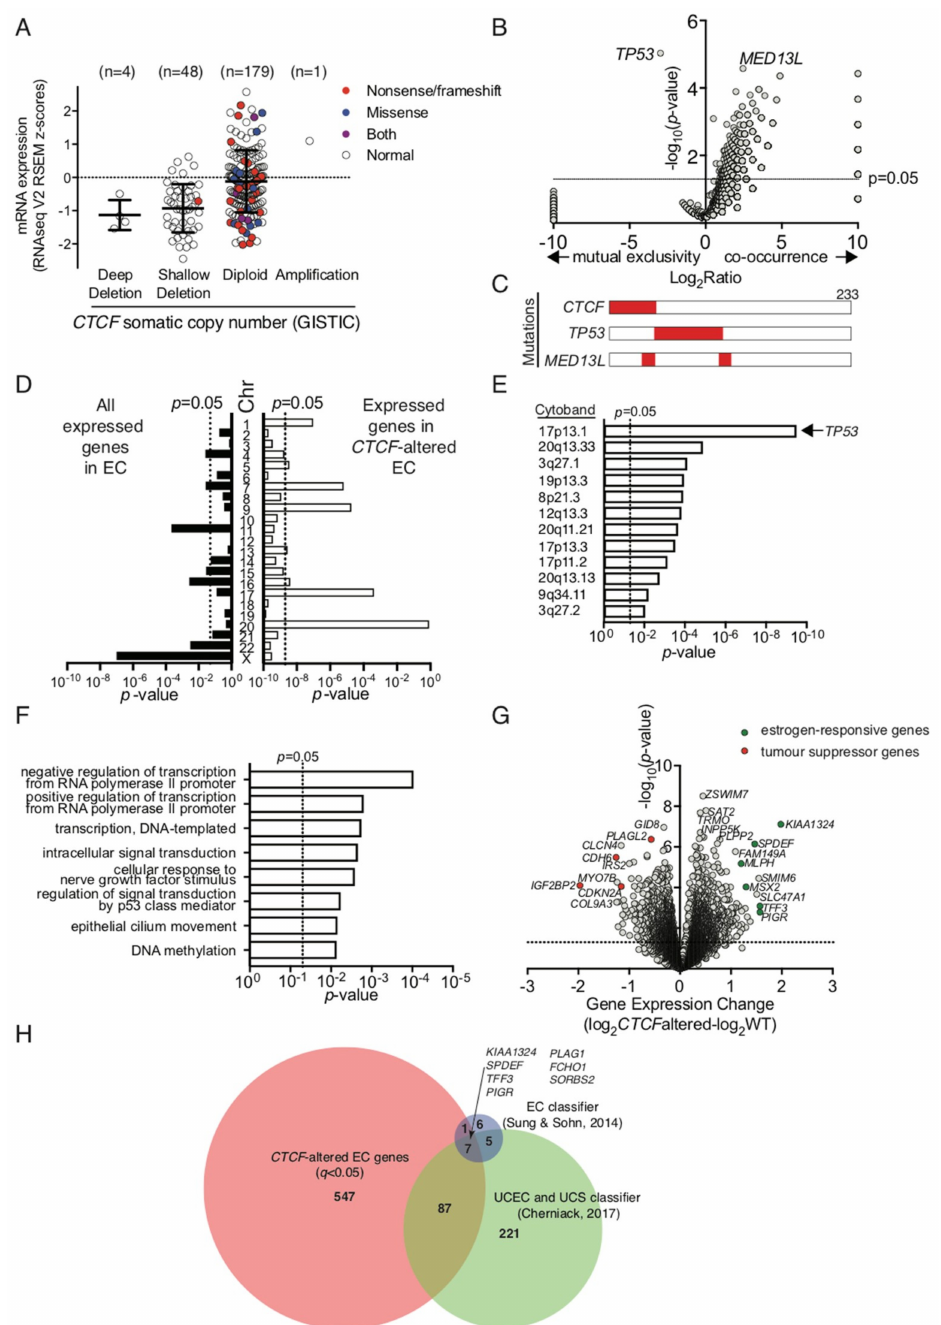
Figure 6. The molecular genetic landscape of CTCF -altered endometrial cancers. Gene expression and DNA sequencing data was analysed from the TCGA endometrial carcinoma patient cohort [28]. ( A ) GISTIC analysis of mRNA expression indicative of somatic copy number alterations in endometrial carcinomas. Filled symbols indicate cancers with CTCF coding region mutations. ( B ) Plot of significantly co-occurring or mutually exclusive mutant genes with CTCF -altered cancer. ( C ) Schematic showing the co-occurrence between CTCF , TP53 and MED13L mutations in endometrial cancer ( n = 233 patient samples). ( D ) Chromosomal distribution of all expressed genes in endometrial carcinoma ( n = 13,271) vs those differentially expressed ( n = 642; q < 0.05) in CTCF -altered cancers (data is normalised for gene density). ( E ) Chromosomal location (cytoband) of genes differentially expressed in CTCF -altered endometrial cancers ( q < 0.05). Data for ( D ) and ( E ) were analysed using the Fisher’s exact test. ( F ) Biological process terms enriched in gene ontology analysis of CTCF -altered endometrial